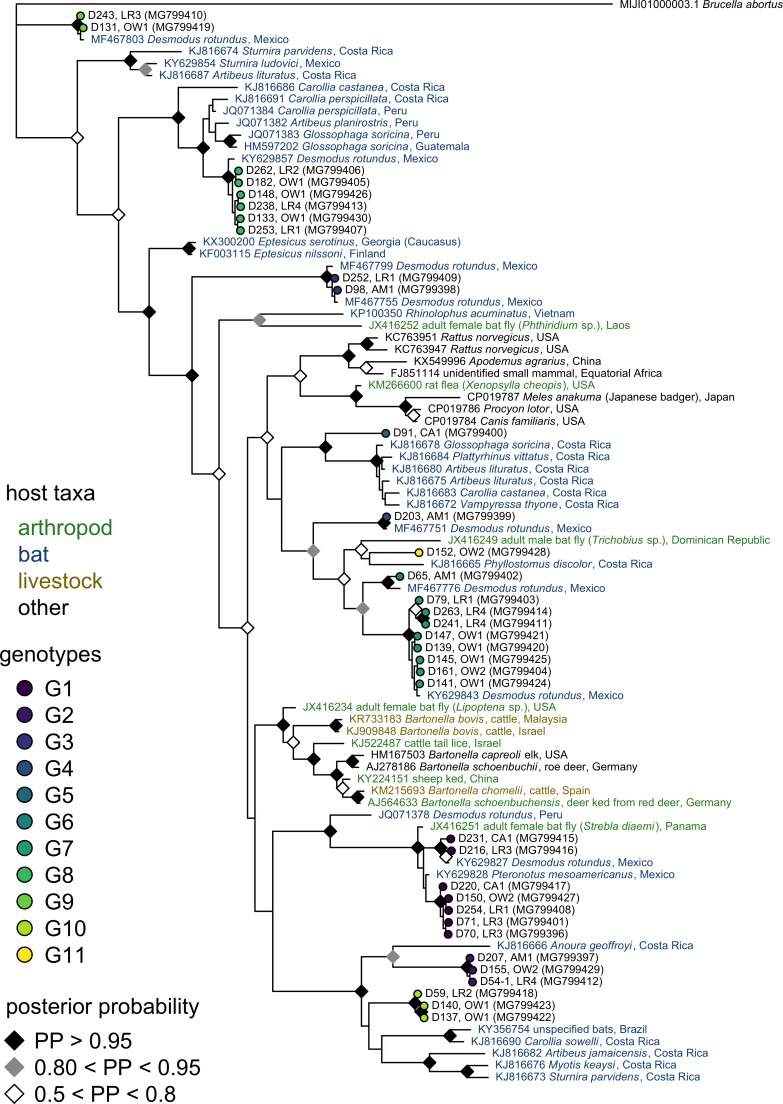
Phylogenetic relationships for the gltA gene among the sample of Bartonella sequences detected in vampire bats and top BLAST hits from GenBank (S3 Table).Bartonella sequences from this study are displayed with genotype, bat ID numbers, and accession numbers. Sequences from GenBank are colored by host taxa and provided with accession numbers, species, and sampling location. Diamonds depict posterior probabilities of nodes greater than 50%.